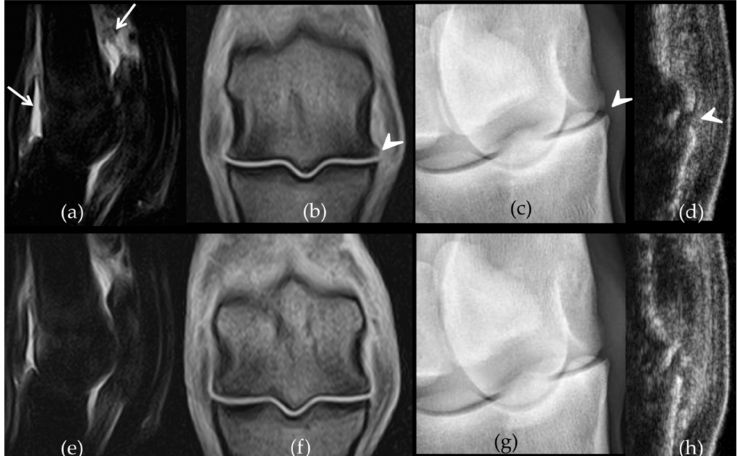
Figure 3. Comparative imaging findings observed on week 12 on the front metacarpophalangeal joints of horse 7. The left fore fetlock ( a – d ) received placebo treatment while the right fore fetlock ( e – h ) received bone-marrow derived mesenchymal stem cells (BM-MSCs) on week 3. On the left fetlock there was grade 3 (white arrows) synovial effusion ( a ) and periarticular osteophytes ( b ) (arrow heads) on Short Tau Inversion Recovery sagittal magnetic resonance imaging (MRI) images ( a ) and T1-weighed dorsal MRI images ( b ) respectively while grade 2 synovial effusion was observed on the right fetlock ( e – f ). Similarly, there are grade 3 (arrow head) osteophytes on the dorsomedial- palmarolateral 35 ◦ oblique radiographic view from the left fore fetlock ( c ) compared to a grade 1 on the right ( g ). The ultrasound osteophyte score was 3 on the left ( d ) (arrow head) and 2 on the right fetlock ( h ), on the longitudinal sections made on the dorso-lateral aspect of both joints.